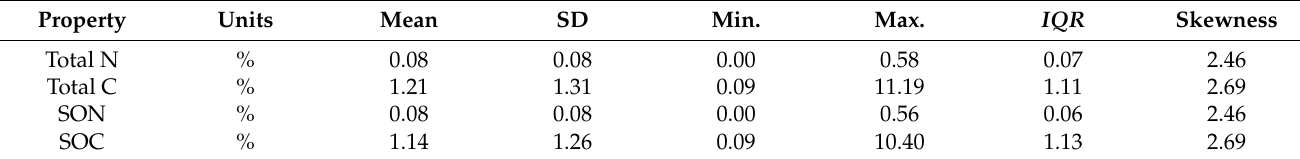
Table A3. Descriptive statistics of properties in the “CN” group.